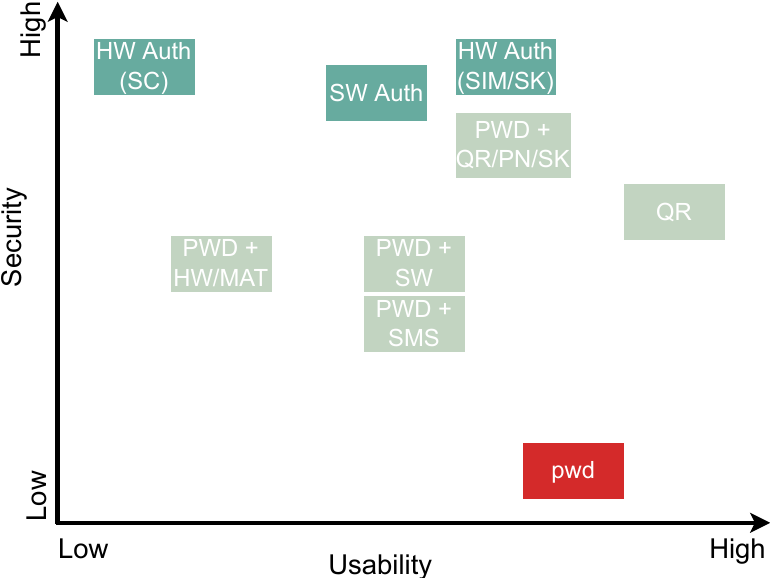
Figure 6. Authenticators’ security vs. usability